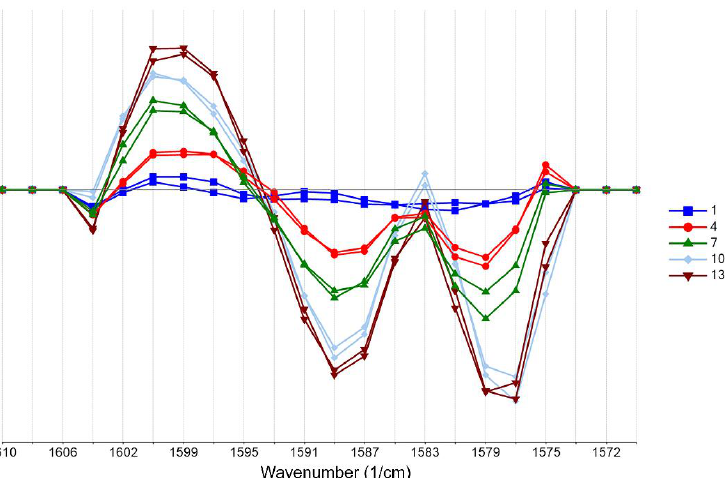
Figure 2. Second derivative transformation with Savitzky–Golay smoothing focusing on the 1600–1500 cm − 1 region of the spectra of the training set (blue: 1 g/L, red: 4 g/L, green: 7 g/L, cyan: 10 g/L, brown: 13 g/L of DS).